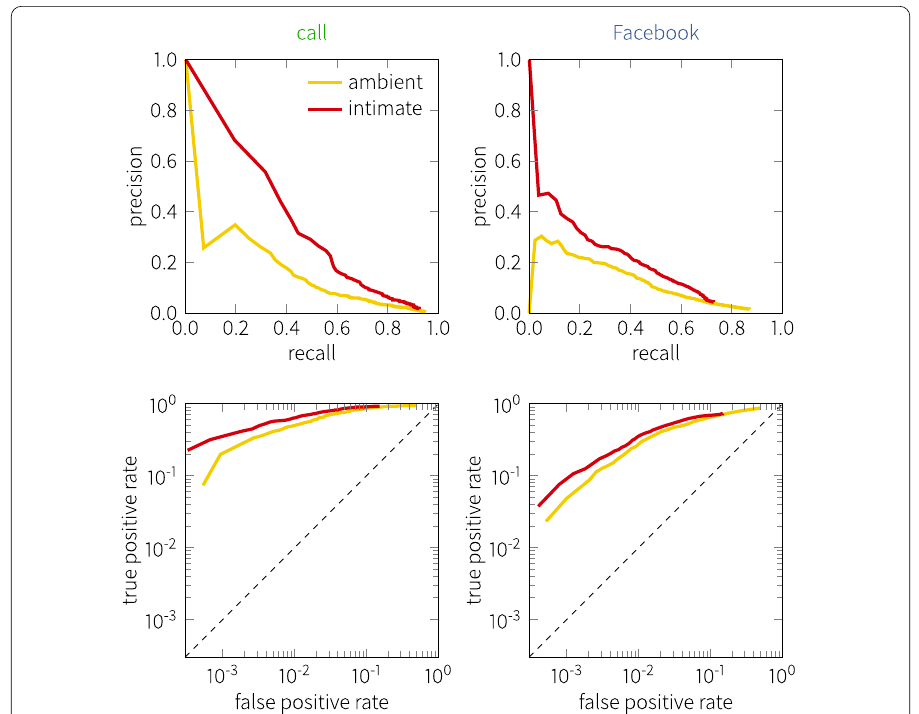
Figure 6 Link overlap between proximity and communication networks. Precision-recall curves (top) and ROC-curves (bottom) in the task of predicting communication links based on the link weights in the proximity networks. In case of ROC, the black dashed line indicates the performance of random